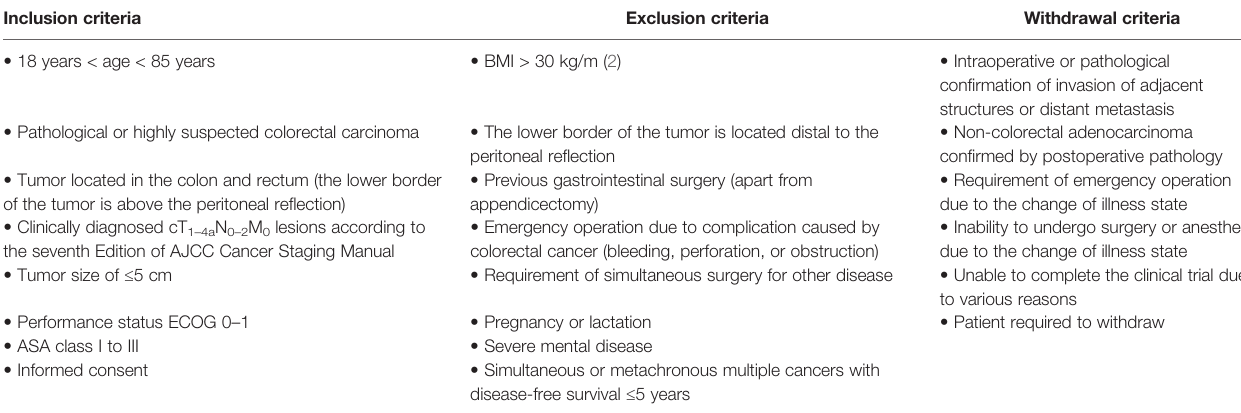
TABLE 1 | Inclusion, exclusion, and withdrawal